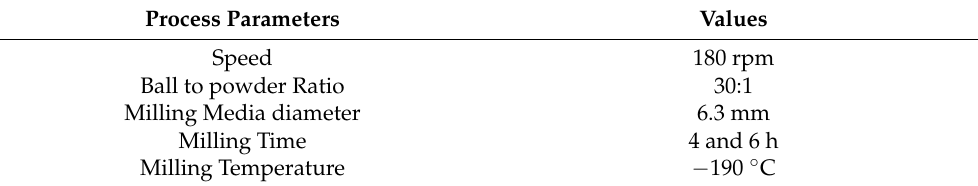
Table 1. Process parameters for the cryomilling